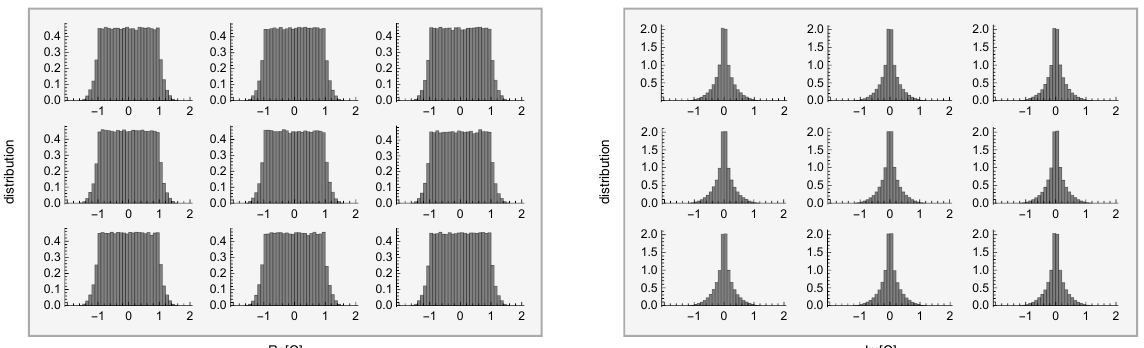
Figure 4. Distribution of the real and imaginary parts of the entries (cid:10) iJ